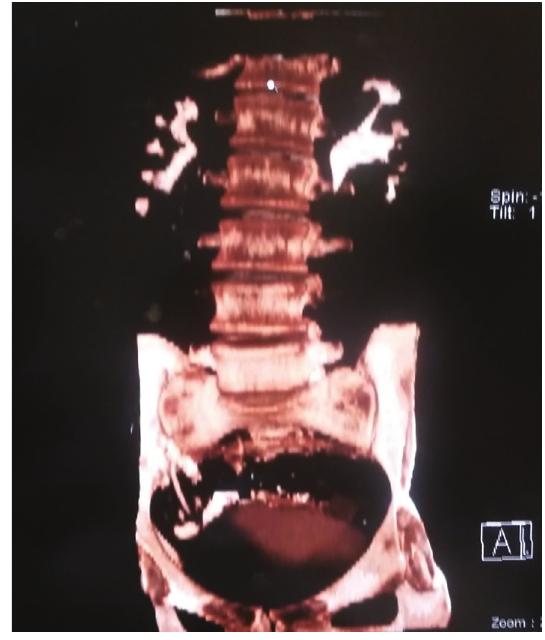
Figure 3 - CT 4 months after appendicoureteroplasty. Normalization of right renal pelvis size. Anastomosis is